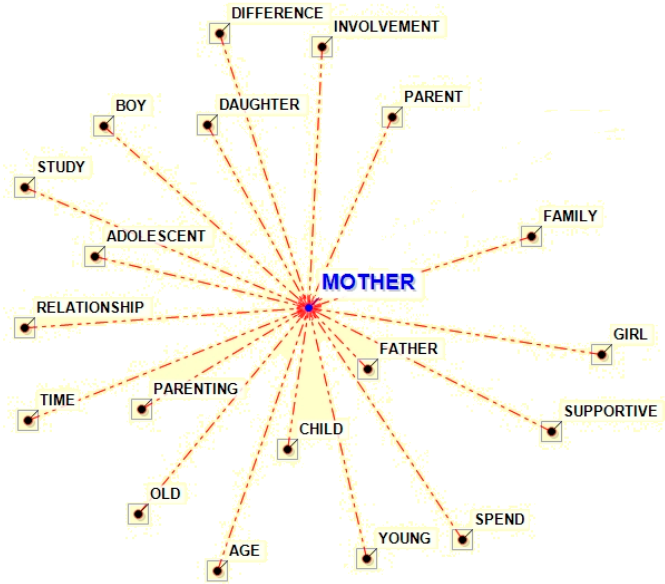
Figure 3. Radial diagram with “mother”.